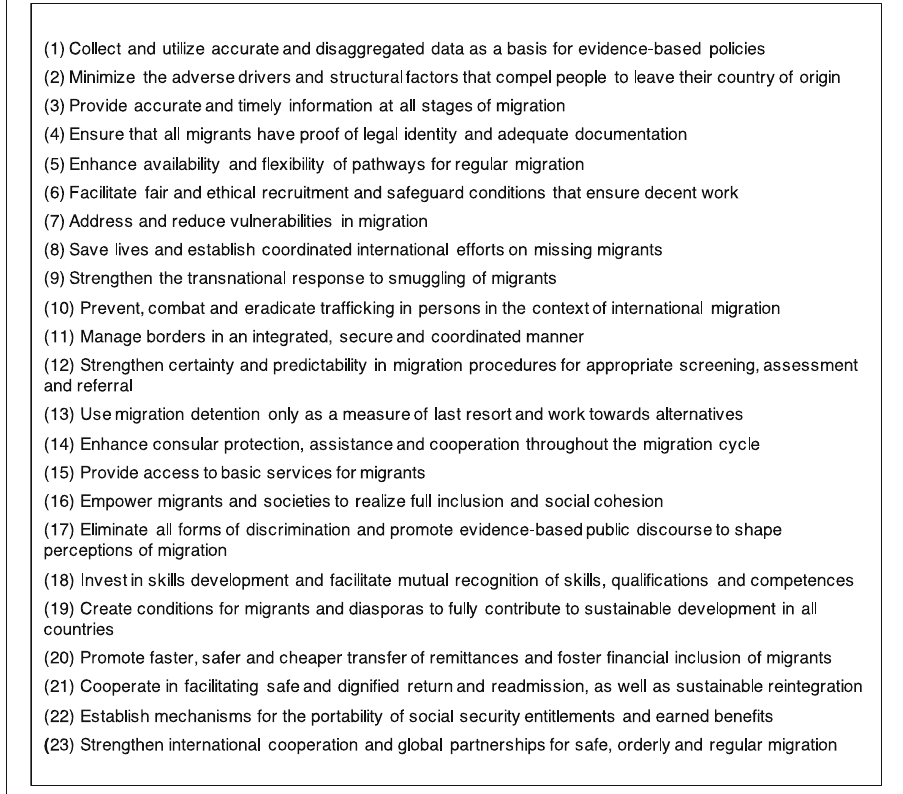
Fig. 1 Global Compact for Safe, Orderly and Regular Migration: